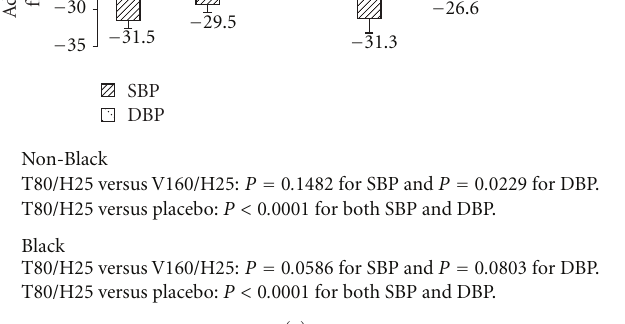
Figure 3: Impact of age (a), gender (b), and race (c) on changes from baseline in BP by treatment group. T80/H25, telmisartan 80mg/hydrochlorothiazide 25 mg: V160/H25, valsartan 160 mg/hydrochlorothiazide